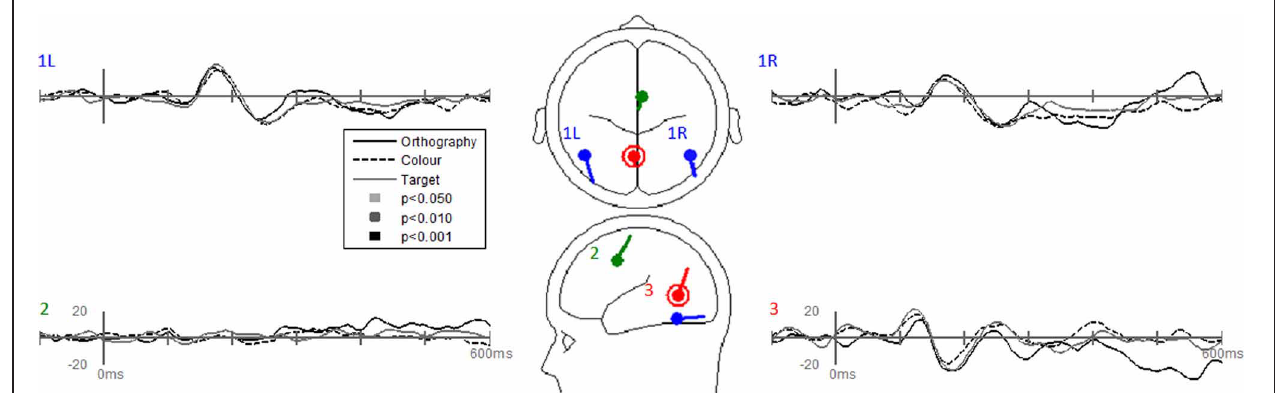
between letter and pseudoletters for each task (Orthography, Color, and Target). No statistical evidence of significant interactions were found in these source waveforms at p < 0 . 05, p < 0 . 01, and p < 0 . 001. Vertical axis scale for waveform plots is in nAmp.